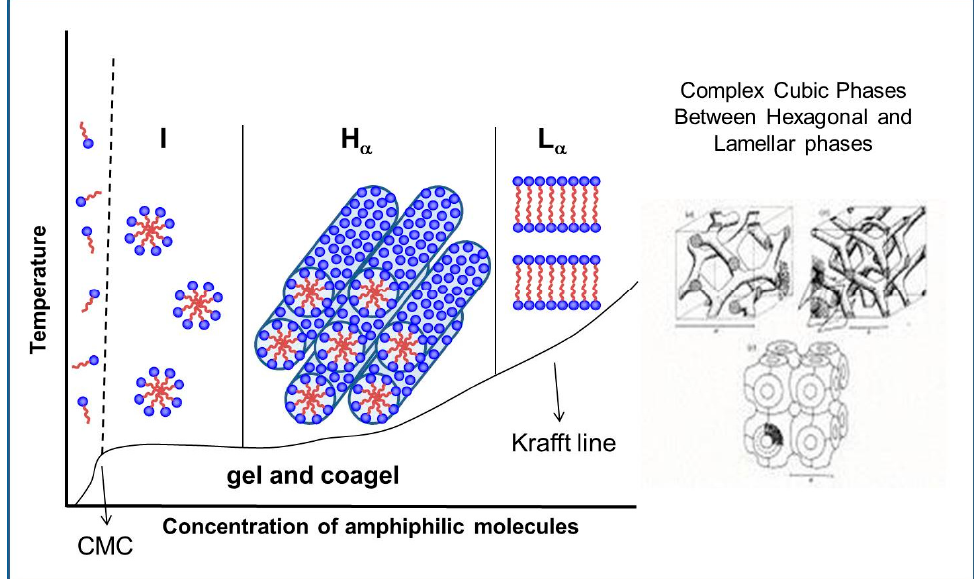
Figure 3. Scheme of phase diagram as a function of concentration and temperature for a lyotropic aqueous system. At the CMC, single molecules form spherical micelles in the isotropic I phase; with increasing concentration, hexagonal H α and lamellar L α phases may form at temperatures above the Krafft line that separates these structures from the gel and coagel crystalline phases. Complex cubic structures may form between the H α and L α phases.